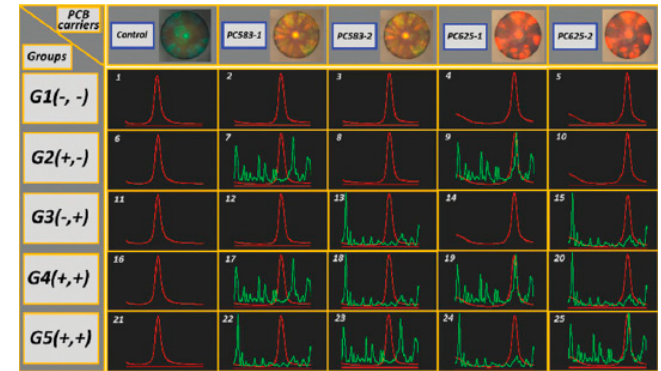
Figure 16. Schematic of the SERS nanotag preparation ( a ); and multiplex bioassays encoded by photonic crystal beads and SERS nanotags ( b ). Reproduced with permission from [42].